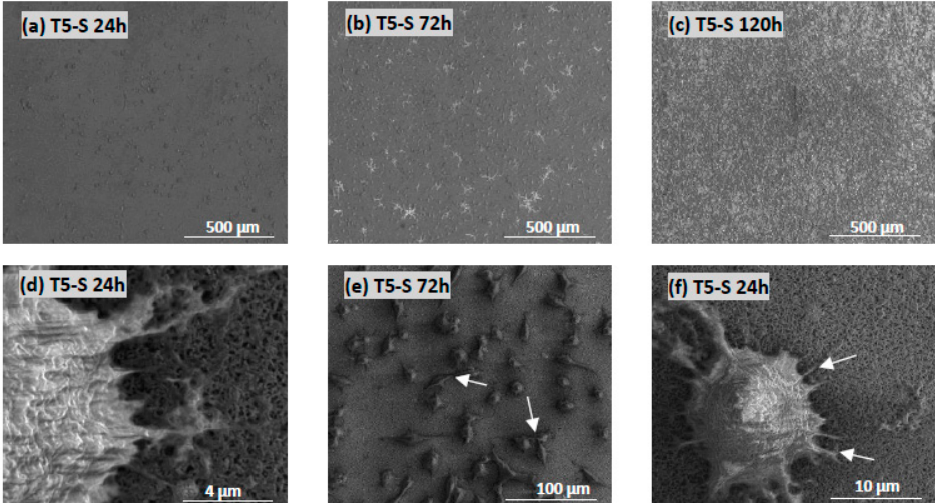
Figure 12. Images obtained by SEM showing L929 fibroblasts that were cultured on the T5-S scaffolds for 24 ( a ), 72 ( b ), and 120 h ( c ). Arrows present the filopodia spreading between fibroblasts ( e ) and the filopodia that attached the cell to the surface of scaffolds ( d , f ).